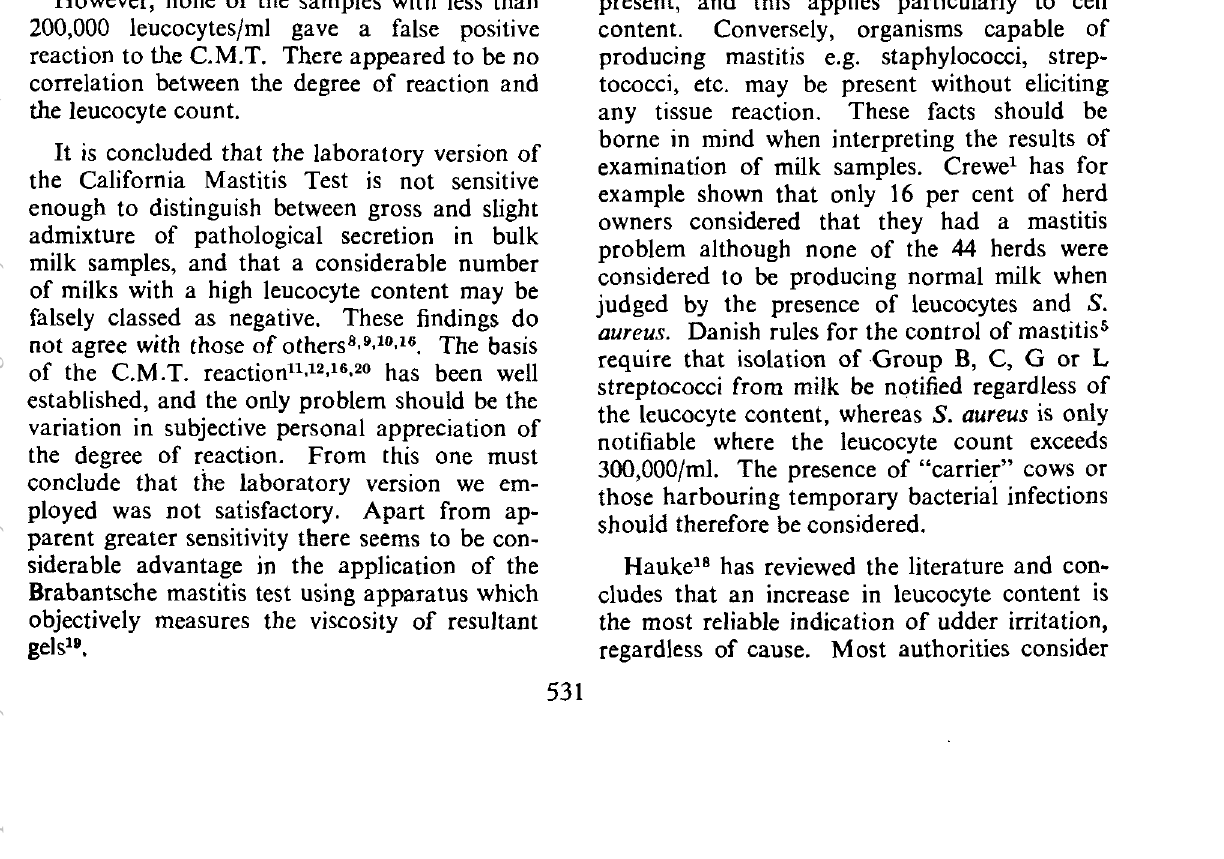
TABLE 5.-FREQUENCY DISTRIBUTION OF posmVE AND NEGATIVE C.M.T.-REACllONS INTERMS OF LEUCOCYTE CONTENT OF Schalm's C.M.T.- Leucocytes/ml Negative grade Negative ... , 4 Trace